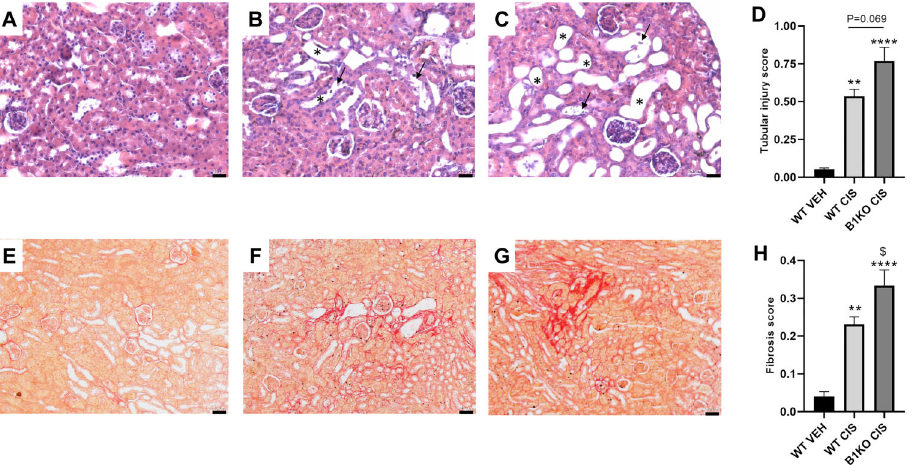
Figure 2. Kinin B1 receptor de fi ciency worsens cisplatin-induced tubular injury and renal fi brosis. Hematoxylin and eosin staining, representative images of wild-type vehicle (WT VEH) ( A ), WT CIS (cisplatin) ( B ), and B1KO CIS ( C ) groups. Asterisks indicate tubular dilation and arrows indicate tubular cell detachment. Scale bars, 25 m m. Tubular injury score ( D ) was determined based on the percentage of tubules showing luminal casts, cell detachment, or dilation. Sirius red-stained representative images: WT VEH ( E ), WT CIS ( F ), and B1KO CIS ( G ) groups. Scale bars= 50 m m. Fibrosis score was determined by Sirius red positive areas ( H ). Data are reported as means ± SE (n=4 – 5 per group). **P o 0.01, ****P o 0.0001 compared to the WT VEH group; $ P o 0.05 compared to the WT CIS group (one-way ANOVA followed by post hoc Tukey ’ s